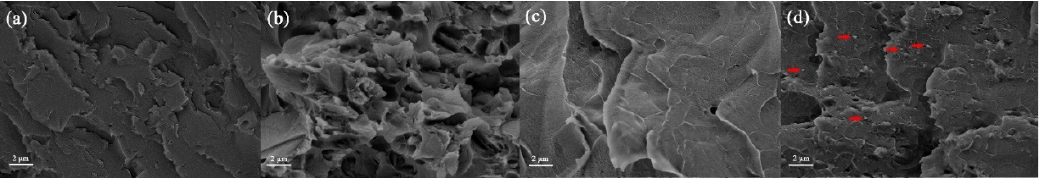
Figure 4. SEM images of the membranes: ( a ) FPGO/SPSU, ( b ) Pt-TiO 2 /FPGO/SPSU-1, ( c ) Pt- TiO 2 /FPGO/SPSU-2, ( d ) Pt-TiO 2 /FPGO/SPSU@-3. TiO 2 /FPGO/SPSU-2, ( d ) Pt-TiO 2